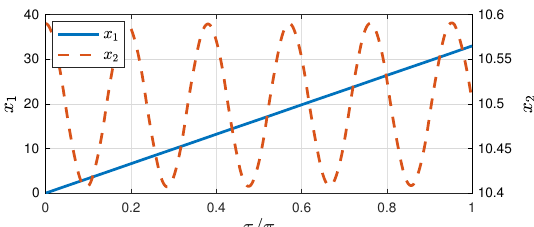
Figure 6. Dynamical behavior of the pendulum under permanent growth of x 1 for a constant value of z 1 > 1 ( η = 0.1428, ω = 0, A = 1.5 and φ =